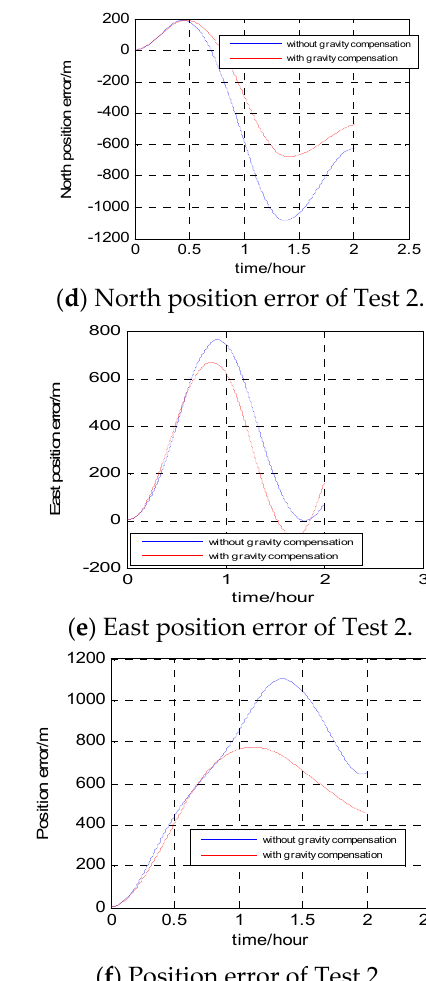
Figure 10. The gravity anomaly and deflections of the vertical (DOVs) of the two tests.